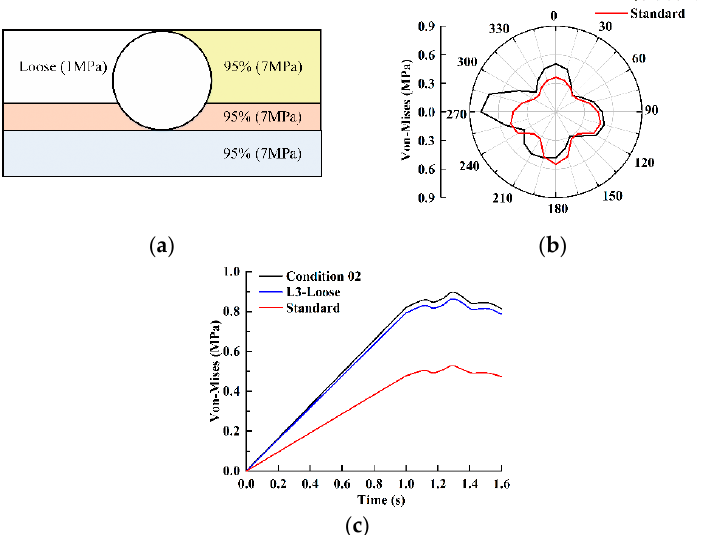
Figure 21. ( a ) The backfilling schematic of Condition 02; ( b ) the stress distribution of the pipe; ( c ) the time history curve of the left springline under Condition 02.